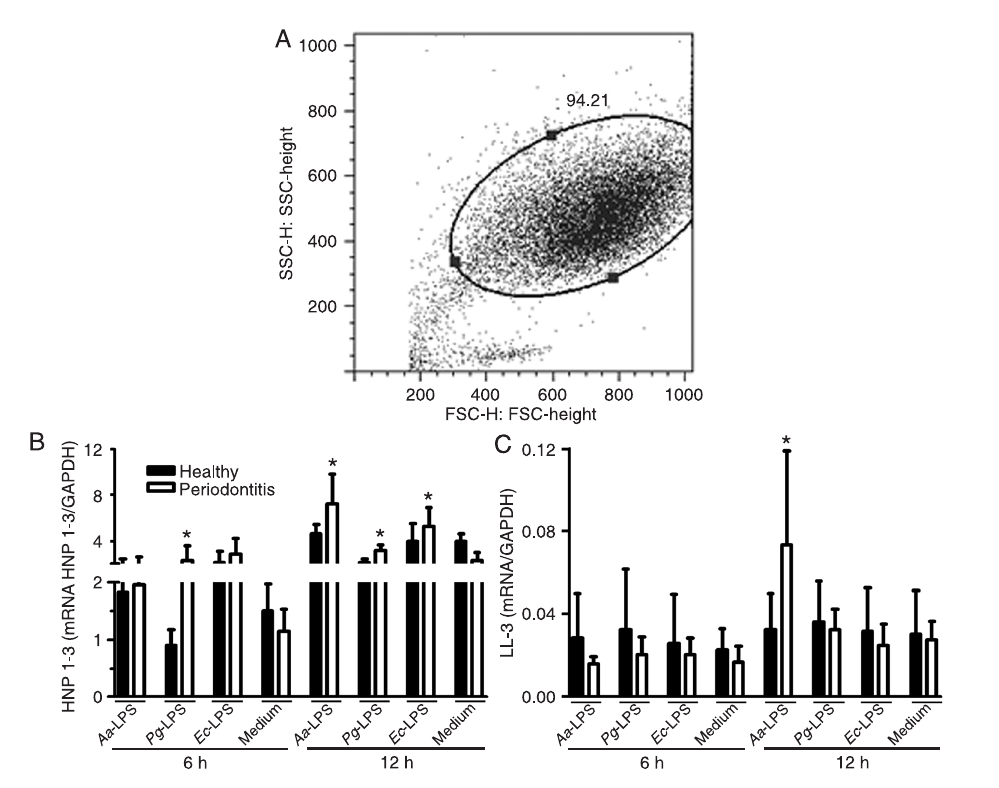
Figure 1. HNP 1-3 and LL-37 mRNA expression in peripheral neutrophils from periodontitis and healthy subjects. Neutrophils were isolated from peripheral blood and analyzed by flow cytometry, showing more than 94% purity according to side scatter (SSC) vs forward scatter (FSC) parameters ( A ). Neutrophils were incubated for 6 and 12 h with culture medium only or with medium containing Aa- LPS (100 ng/ mL), Pg- LPS (100 ng/mL) or Ec- LPS (100 ng/mL). The relative mRNA expression of HNP 1-3 ( B ) and LL-37 ( C ) in neutrophils was assessed by qRT-PCR. Data are reported as means ± SD for N = 6 in each group. Aa- LPS = Aggregatibacter actinomycetemcomitans- lipopolysaccharide; Pg- LPS = Porphyromo- nas gingivalis- LPS; Ec- LPS = Escherichia coli- LPS. *P ≤ 0.05, periodontitis compared to healthy subjects (Student t -test).